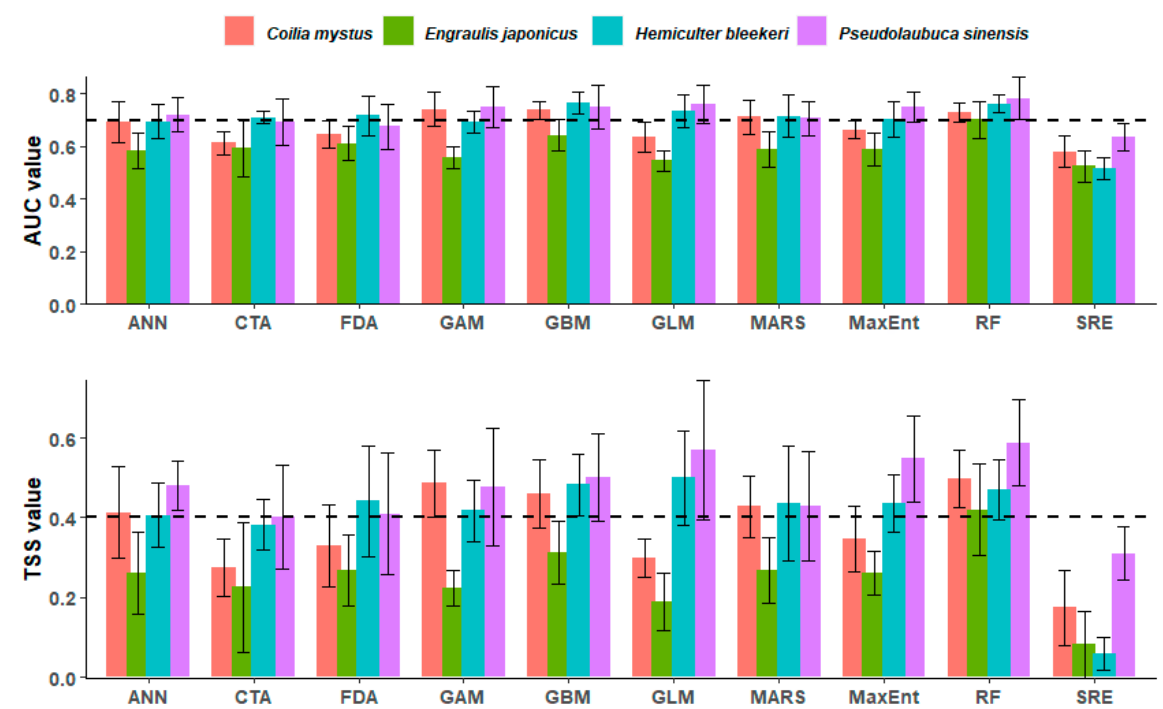
Figure 2. Predictive abilities of the ten modelling algorithms (artificial neural networks (ANN), classification tree analysis (CTA), flexible discriminant analysis (FDA), generalized additive model (GAM), generalized boosting model (GBM), generalized linear model (GLM), multiple adaptive regression splines (MARS), maximum entropy (MaxEnt), random forest (RF), and surface range envelop (SRE)) for the four larval fish. Dashed lines represent cutoff levels for the area under the receiver operating characteristic curve (AUC = 0.7) and true skill statistic (TSS = 0.4) used to select the algorithms to remain in the ensemble species distribution models (SDMs). Values are expressed as mean ± standard error. Table 2. Predictive abilities of ensemble species distribution models (SDMs) for each larval fish species.